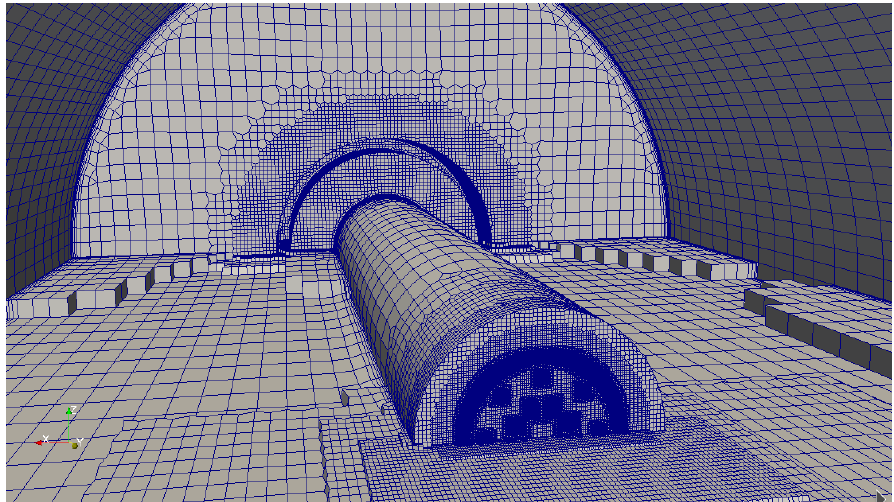
Figure 2. Mesh inside of the kiln with a modified (annular) secondary air inlet. The figures show the multi-nozzle burner and cooling slot in the foreground, the burner pipe and the rectangular secondary air inlet channel in the background. For increased visibility, a coarse mesh is shown